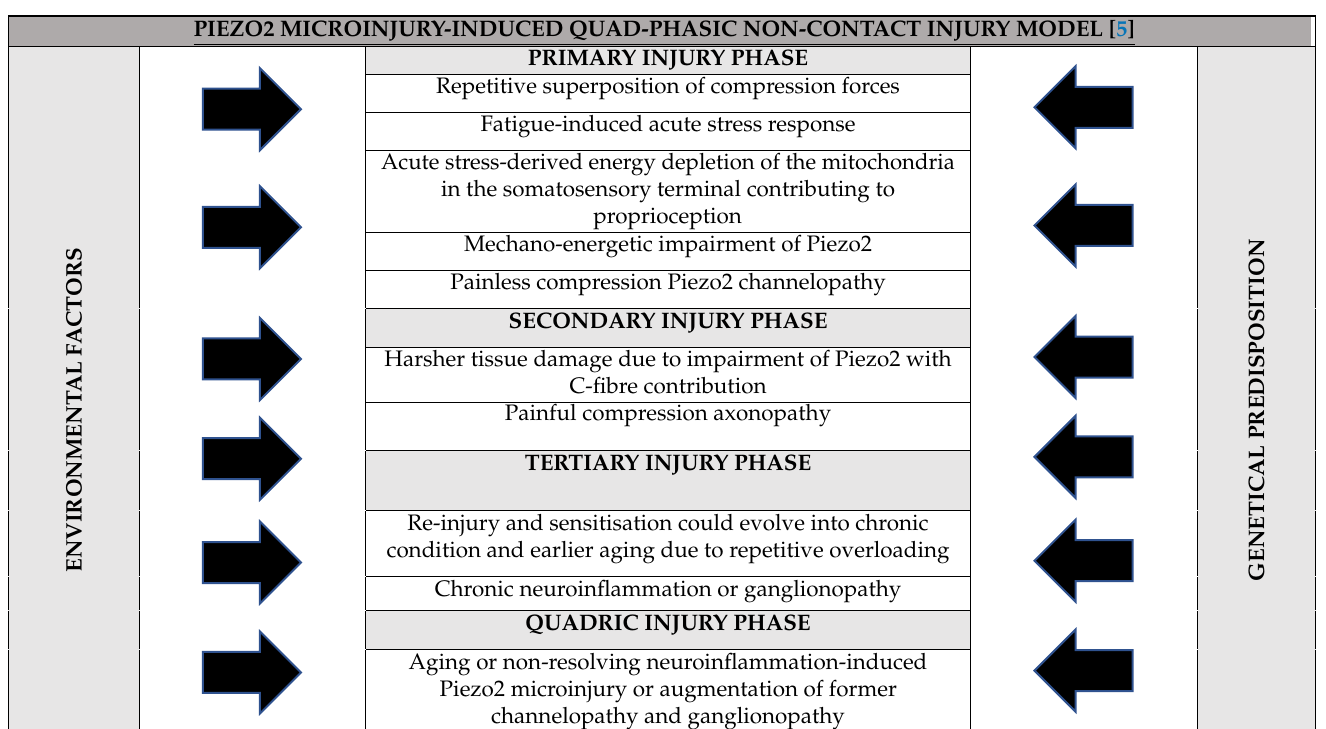
Table 1. The quad-phasic non-contact injury model [5].